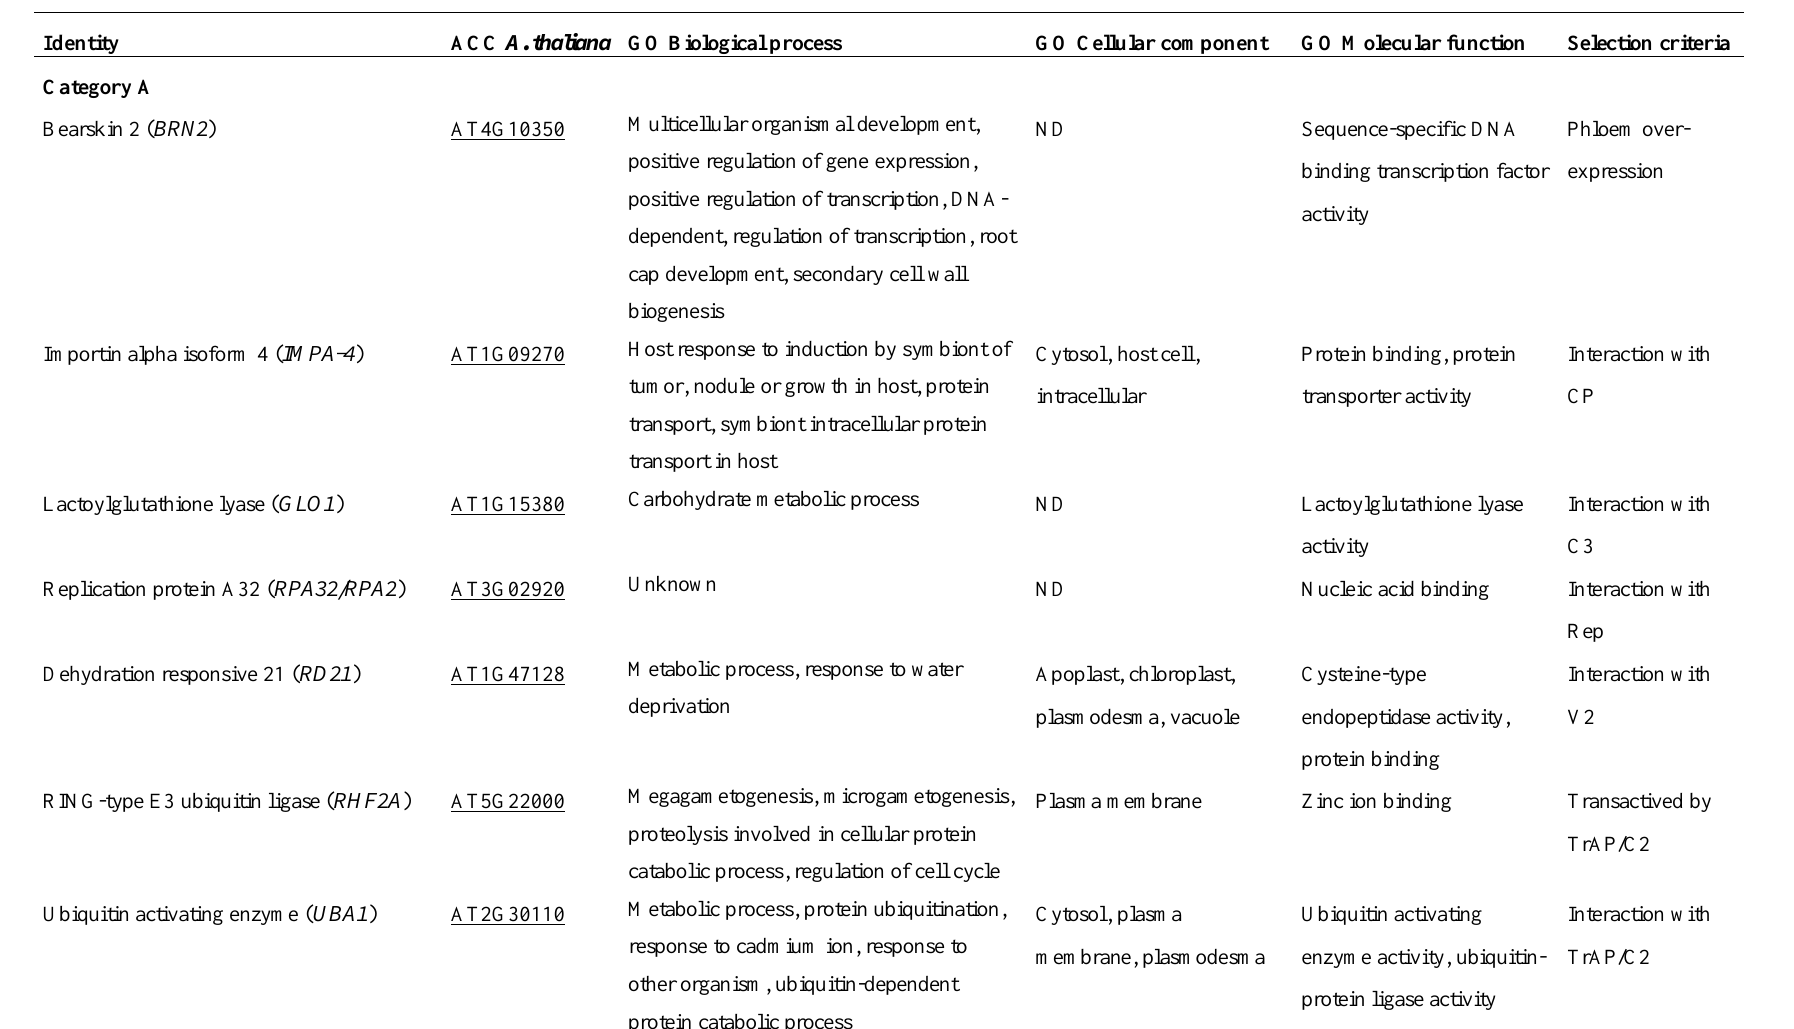
Table 1 . List of genes whose silencing enhances (category A) or delays (category B) TYLCSV infection. The criterion for selection is indicated in each case. The accession numbers (ACC) of the homologous Arabidopsis gene used in the VIGS experiments are indicated. ND: not